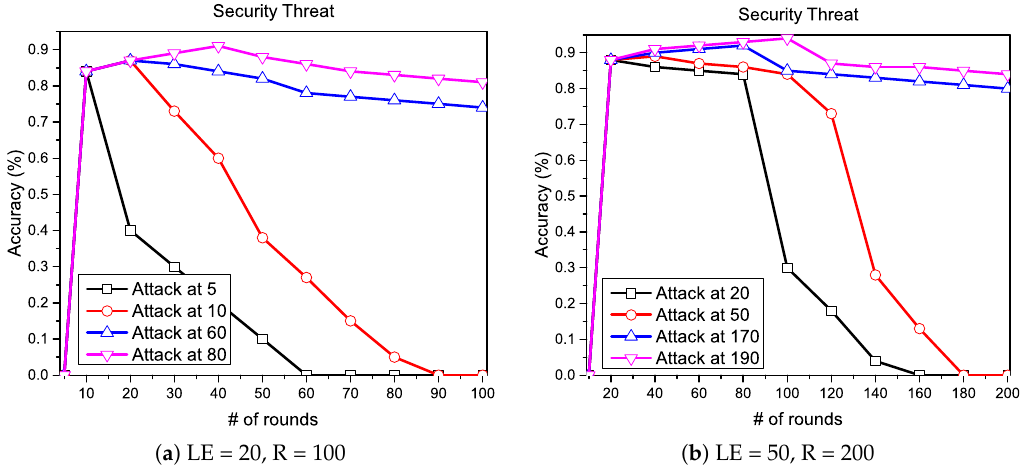
Figure 5. Backdoor injected at various numbers of communication